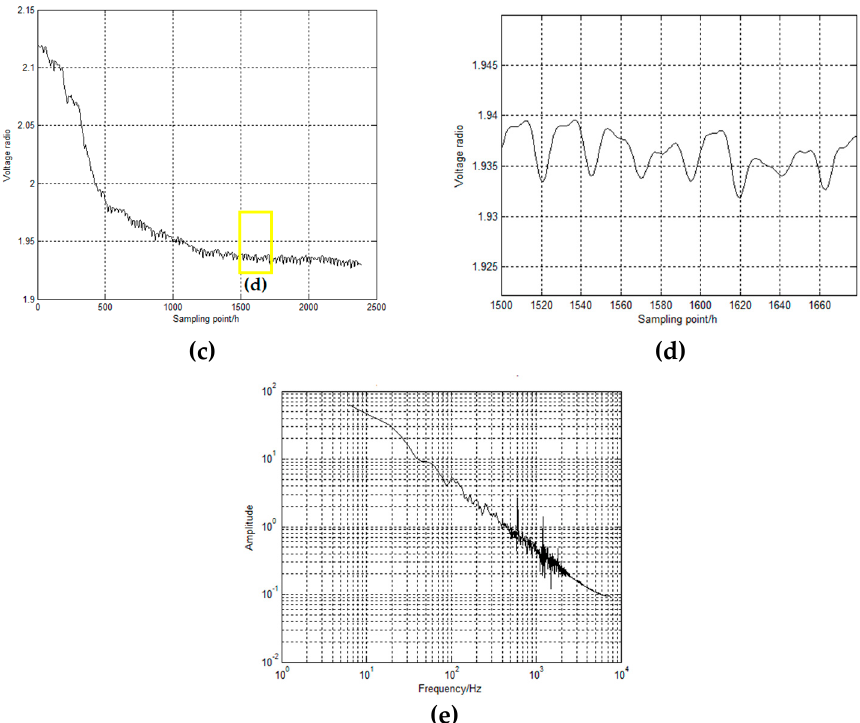
Figure 7. The denoised corrosion data. ( a ) Origin corrosion data; ( b ) Origin corrosion data spectrum(log-log); ( c ) Denoised corrosion data; ( d ) Detailed denoised corrosion data. ( e ) Denoised corrosion data spectrum (log-log).